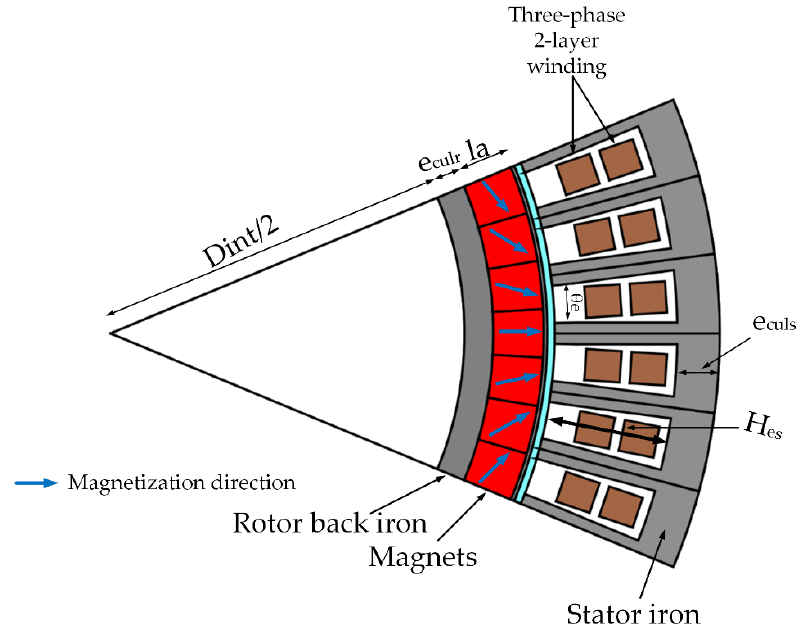
Figure 6. Geometry of the machine having seven magnet segments per pole.